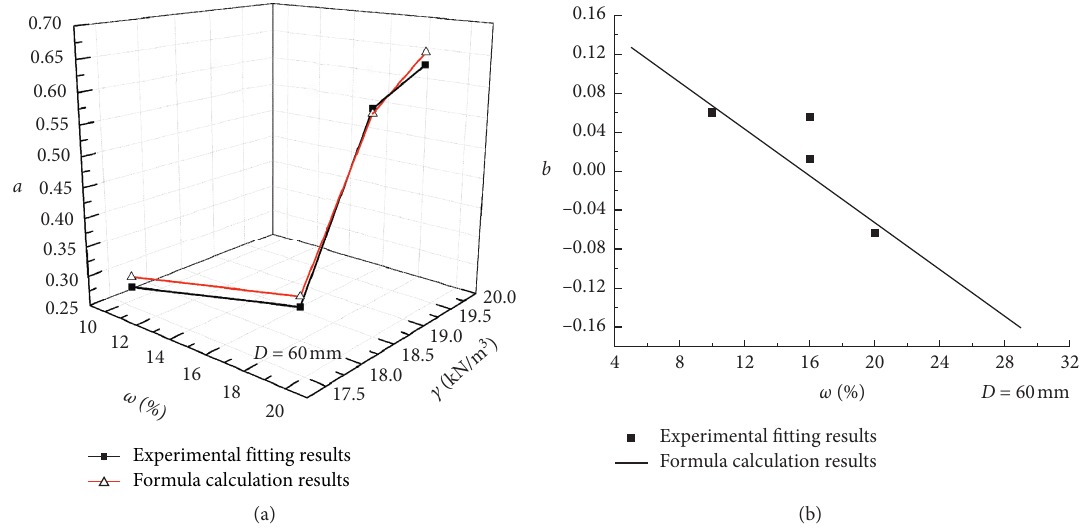
Figure 14: Comparison between the result via formula and test result. (a) Variation of parameter a with ω and c . (b) Relationship between parameter b and ω.